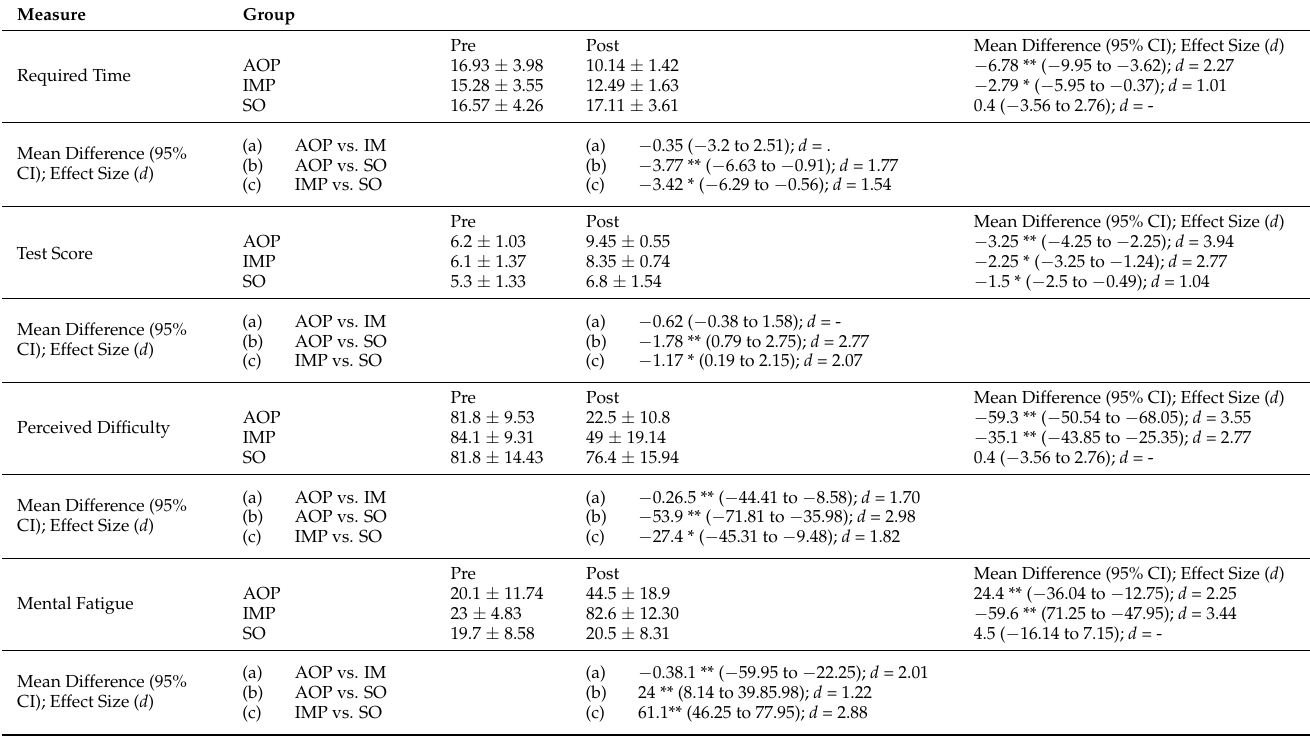
Table 2. Main results obtained.